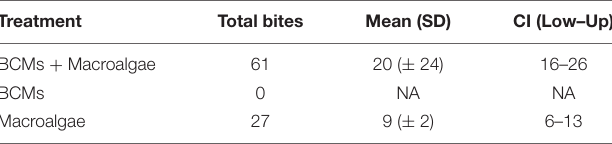
TABLE 2 | Number of bites in the susceptibility to herbivory tests of BCMs and macroalgae in single and mixed